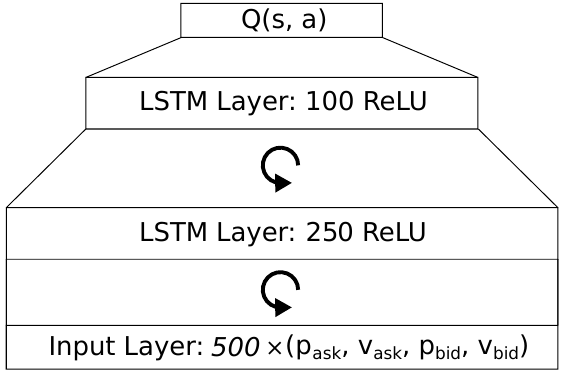
Figure 4. A more sophisticated LSTM architecture for a real-world